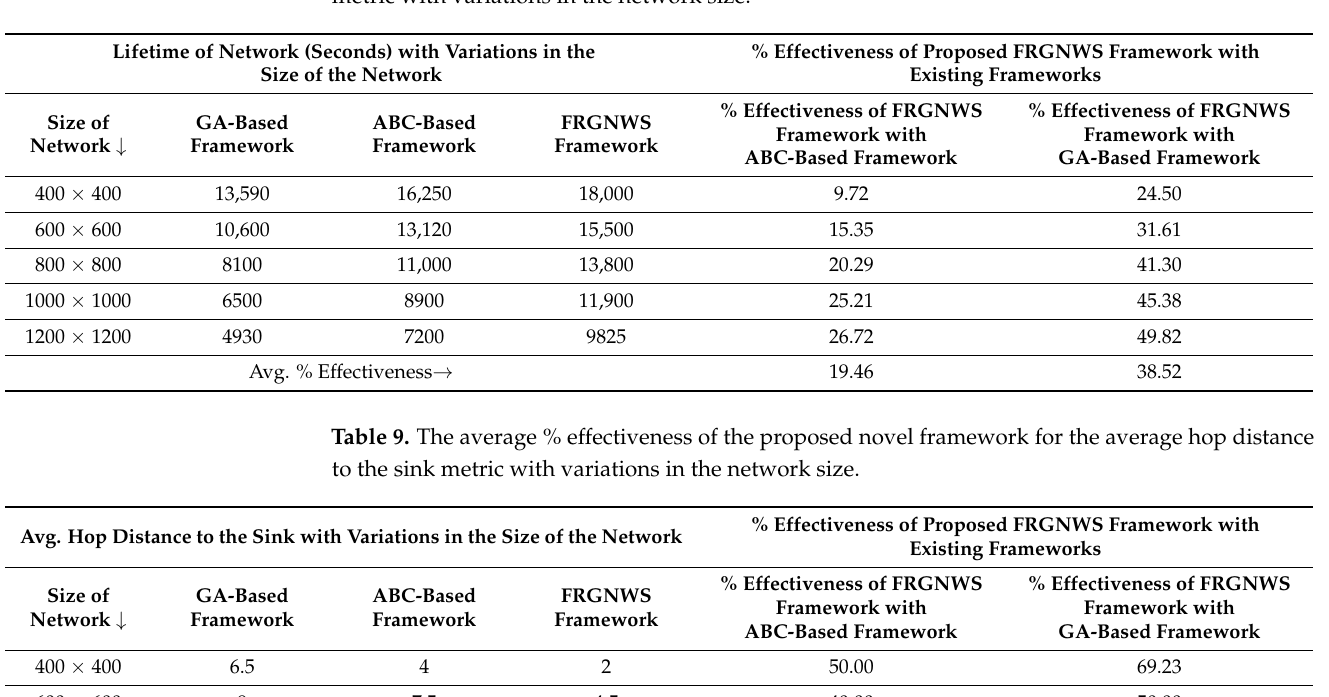
Table 8. The average % effectiveness of the proposed novel framework for the lifetime of the network metric with variations in the network size.